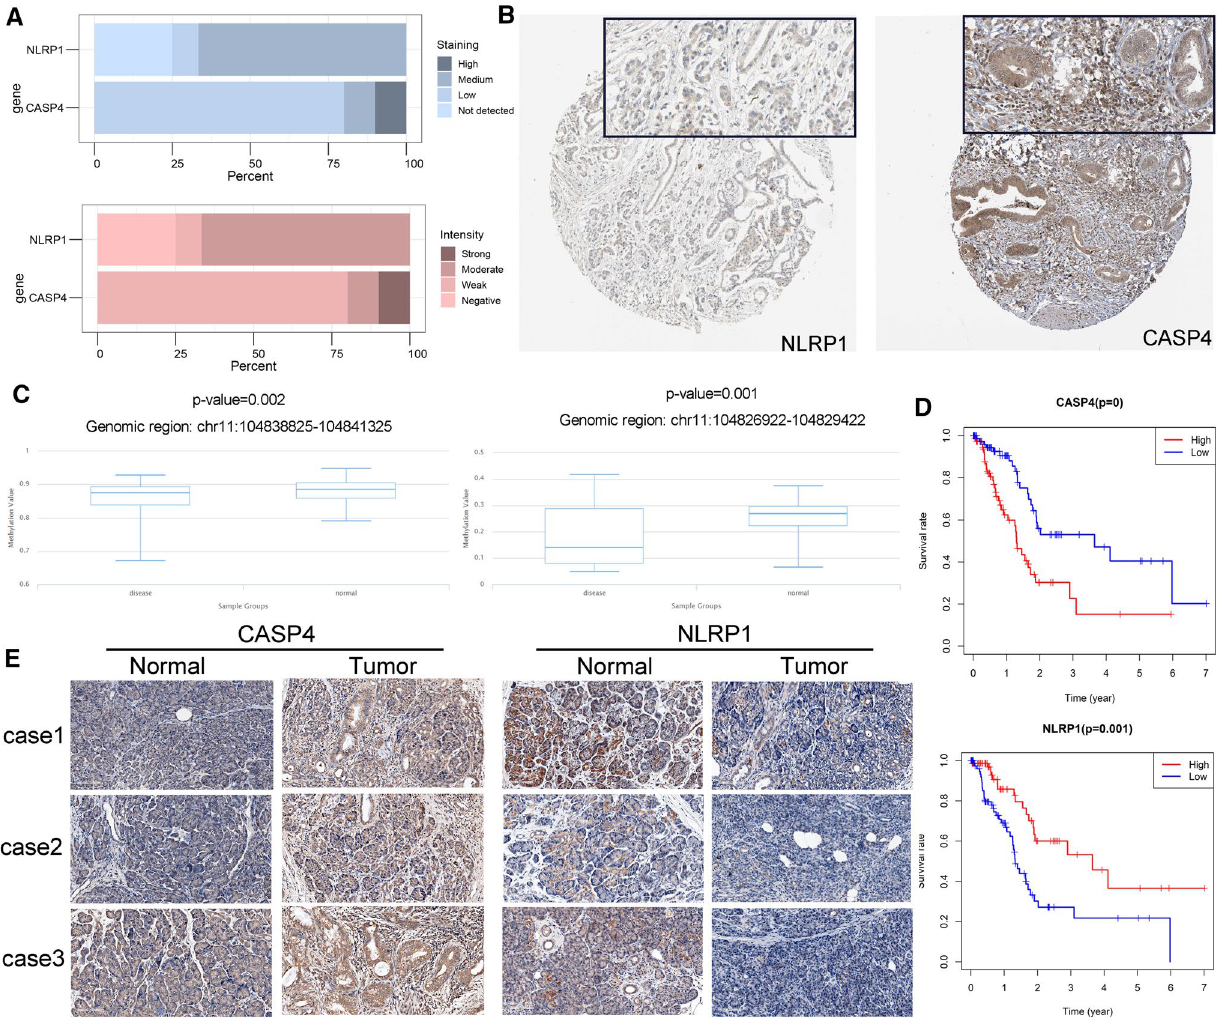
Fig. 5 Expression and survival analysis of PRGs in PDAC. A The protein expression score of staining and intensity of NLRP1 and CASP4 pro- teins in all PDAC samples (HPA database). Protein expression score is based on immunohistochemical data manually scored with regard to staining intensity (negative, weak, moderate or strong) and fraction of stained cells (< 25%, 25–75% or > 75%). B Immunohistochemi- cal staining of NLRP1 and CASP4 proteins in PDAC. C Methylation levels of CASP4 at chr11:104838825–104841325 and chr11:104826922– 104829422 in PDAC and para-cancer tissues. D The OS survival curves of NLRP1 and CASP4 mRNA expression level in PDAC. E CASP4 and NLRP1 immunohistochemistry for patients from Zhongnan Hospital